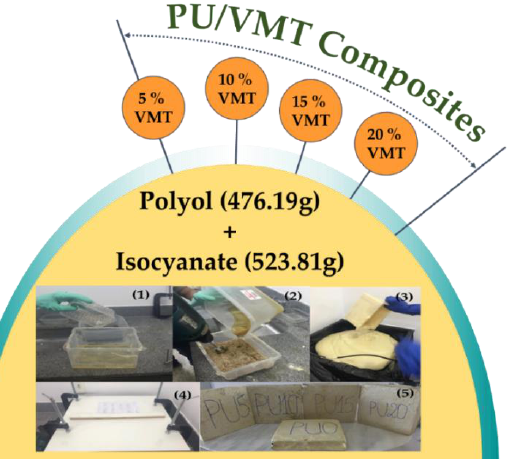
Table 1. PU/VMT composite formulations.